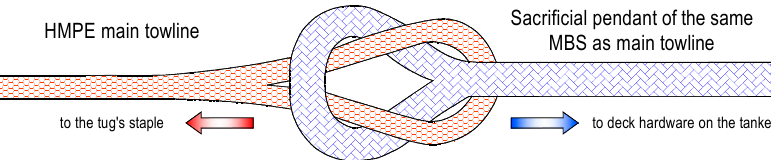
Figure 14. Cow hitch connecting HMPE towline to a sacrificial pendant. Drawing: Authors. To compensate for the loss of grip due to its low COF, a HMPE towline requires around twice as many wraps in the drum winch than a polyester one to achieve the same holding power. However, on an equal strength by strength basis, its diameter is approximately half, so the drum width can remain the same